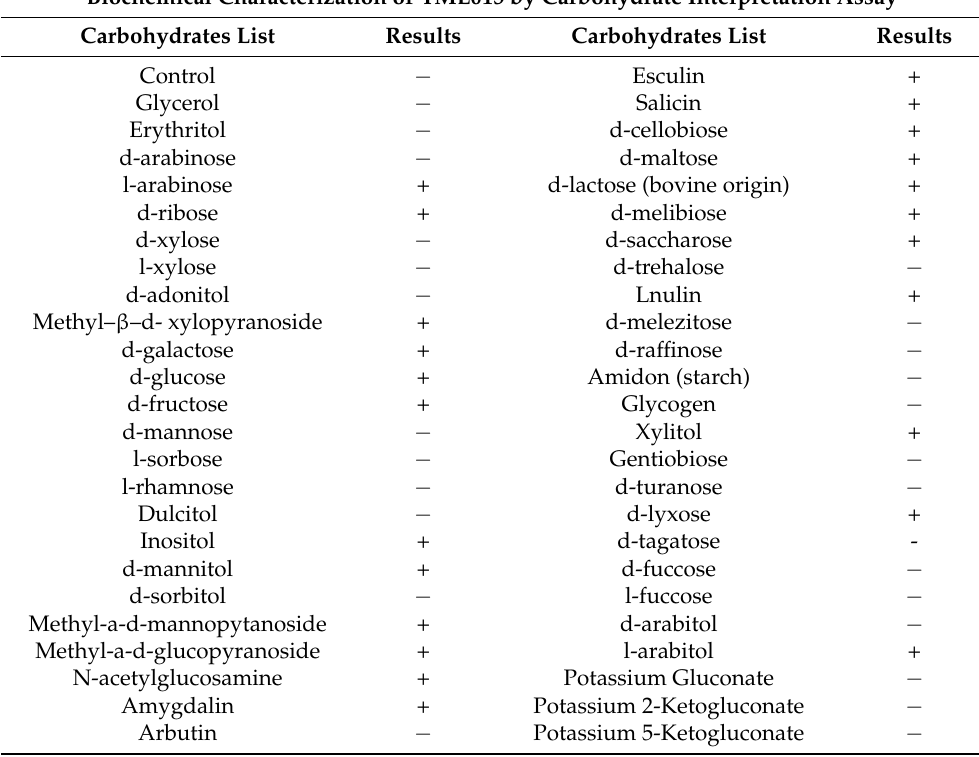
Table 1. Biochemical test by carbohydrate interpretation assay (API 50 kit).